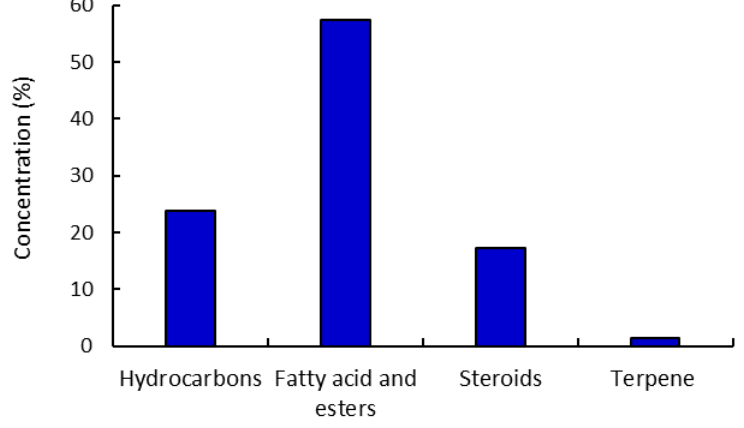
Figure 3. The categorized chemical constitutes identified from the extracted R. tingitana by GC-MS analysis.